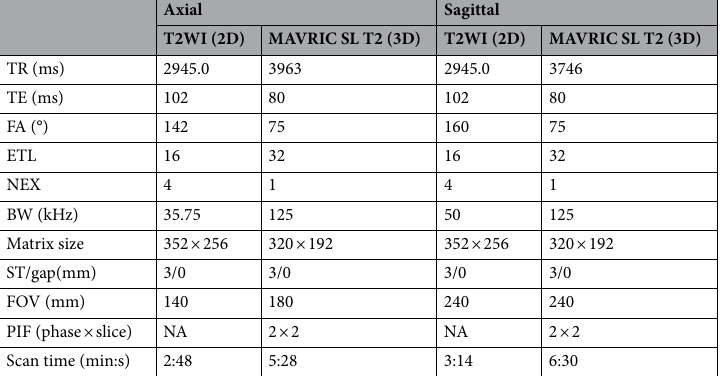
(Table 3). All volunteers underwent MRI scans with axial and sagittal T2WI and MAVRIC SL T2 sequences. A 3 T MR system (Architect, General Electric, Waukesha, WI, USA) was used with a head and neck coil. Scans